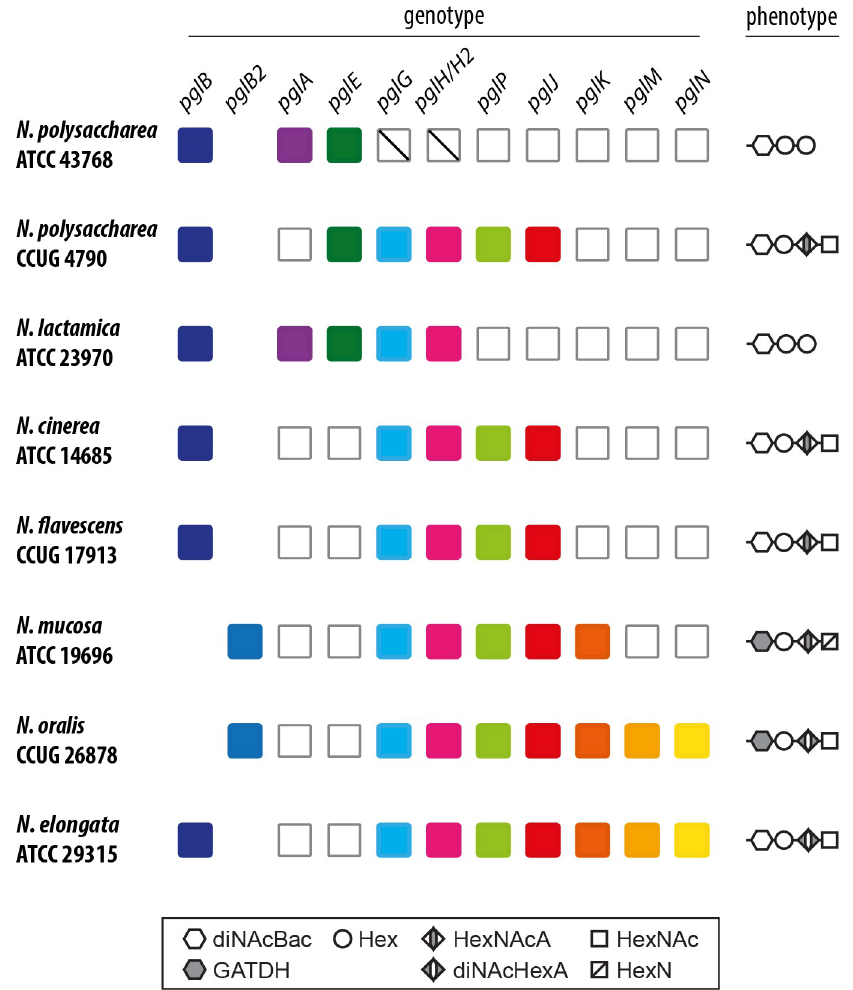
Fig 5. Genotype / phenotype relationships associated with glycan structures in select commensal strains. All strains used are species type strains. See Figs 3 and 4 for